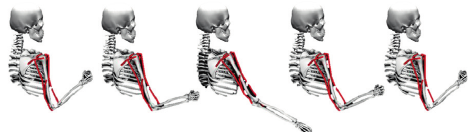
Figure 2: The reaching task illustration of the